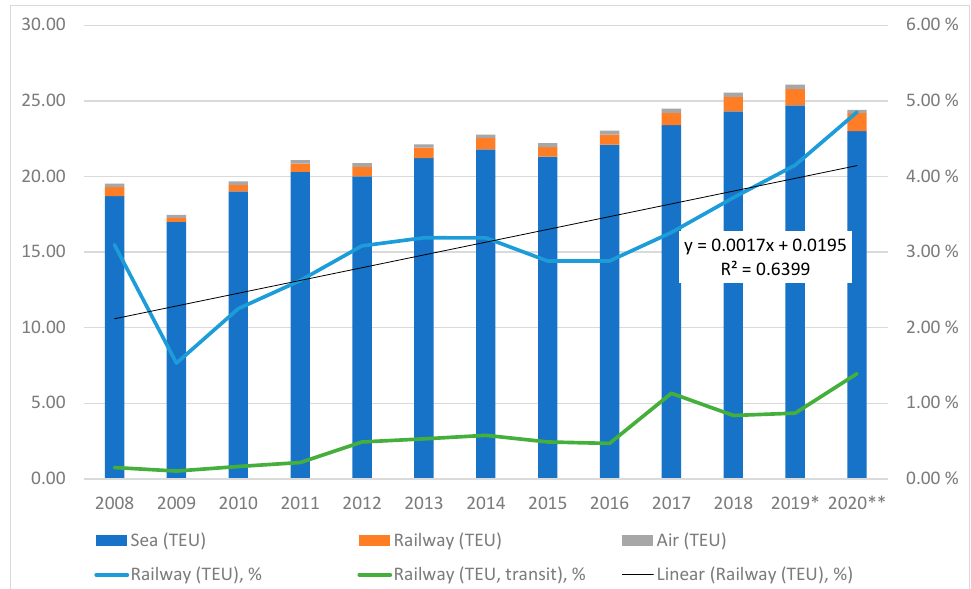
Figure 2. Container transportation volumes between Asia and Europe within three different transportation modes (air freight converted to TEU with assumption of 10 ton per TEU container; million TEU). Denotation: *, railway container volumes estimated with data ending to August 2019; **, railway container volumes estimated within international transports with an average growth in 2009–2018; railway data based on Coordinating Council on Trans-Siberian Transportation and International Coordinating Council on Trans-Eurasian Transportation (CCTST/ICCTET) [16]; air freight estimated with first three quarters of 2020 [15]; sea containers based on Unctad [7].